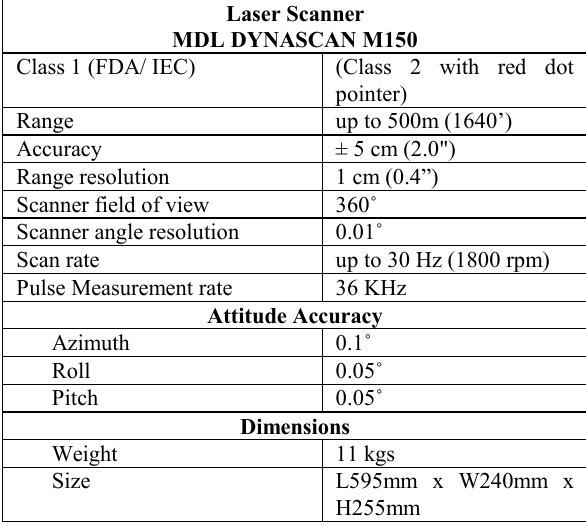
Table 1. Technical features of the MDL DYNASCAN M150.